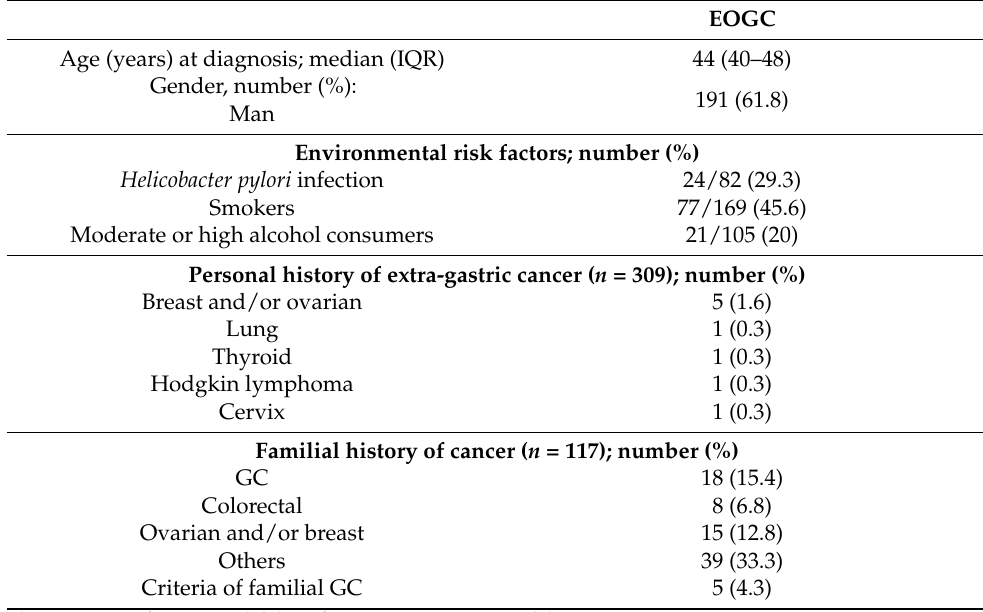
Table 1. Clinical characteristics of the patients (N =